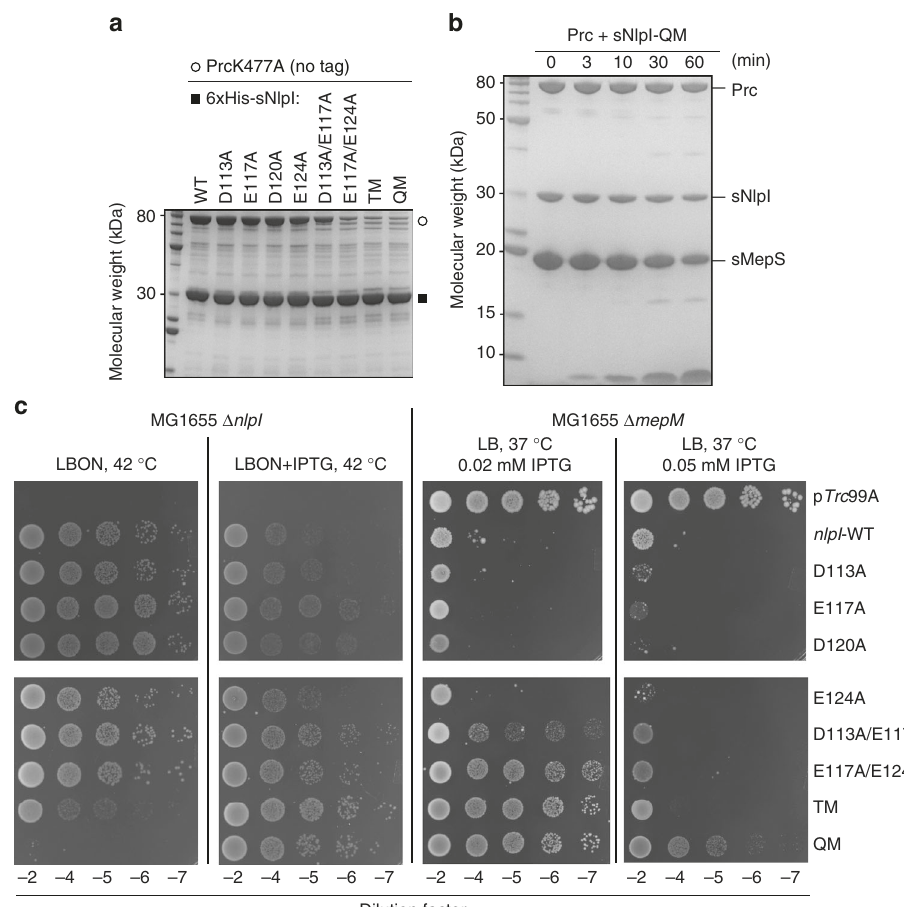
Fig. 5 Mutational analysis of NlpI on Prc interaction. a Pull-down assays of Prc-K477A by wild-type (WT) or various mutants of 6×His-tagged sNlpI. b SDS- PAGE assay monitoring substrate degradation by Prc and sNlpI-QM. c Effects of NlpI mutations in cells of MG1655 Δ nlpI or MG1655 Δ mepM containing p Trc 99A or pCHT93 carrying the WT or mutant NlpI derivatives. Cultures were grown in LB broth with ampicillin and 5 µ l of various dilutions were spotted on indicated plates and grown overnight. TM, triple D113A/E117A/E124A mutant; QM, quadruple D113A/E117A/D120/E124A